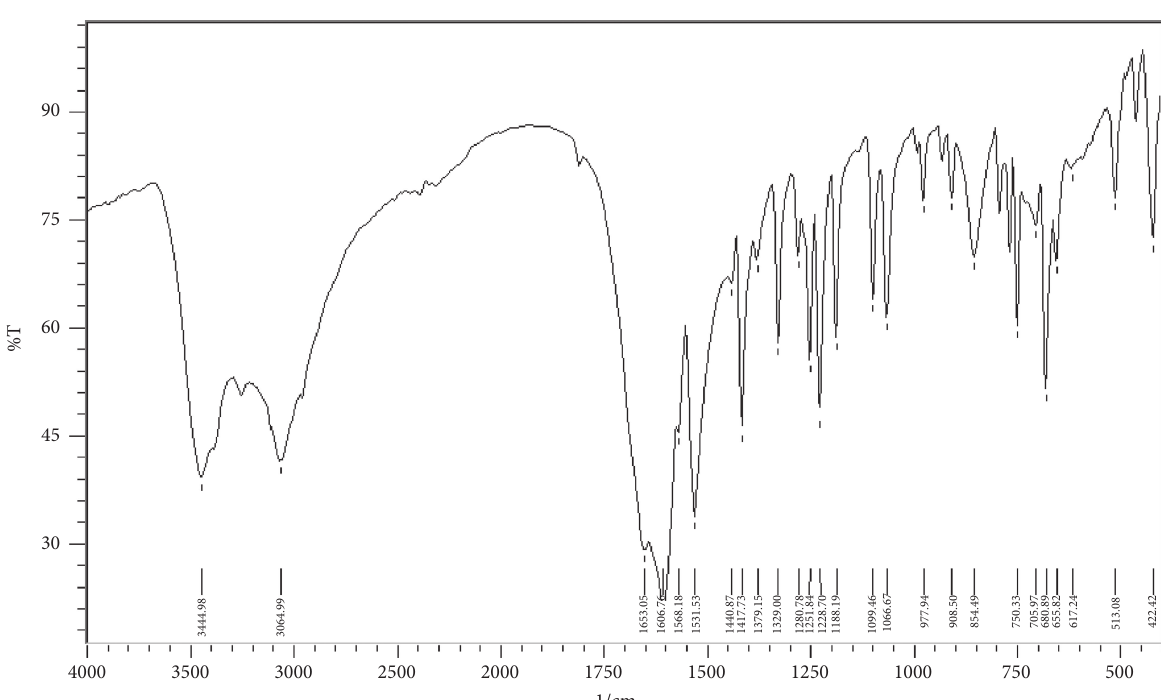
Figure 9: Infrared spectrum of cobalt complex as KBr